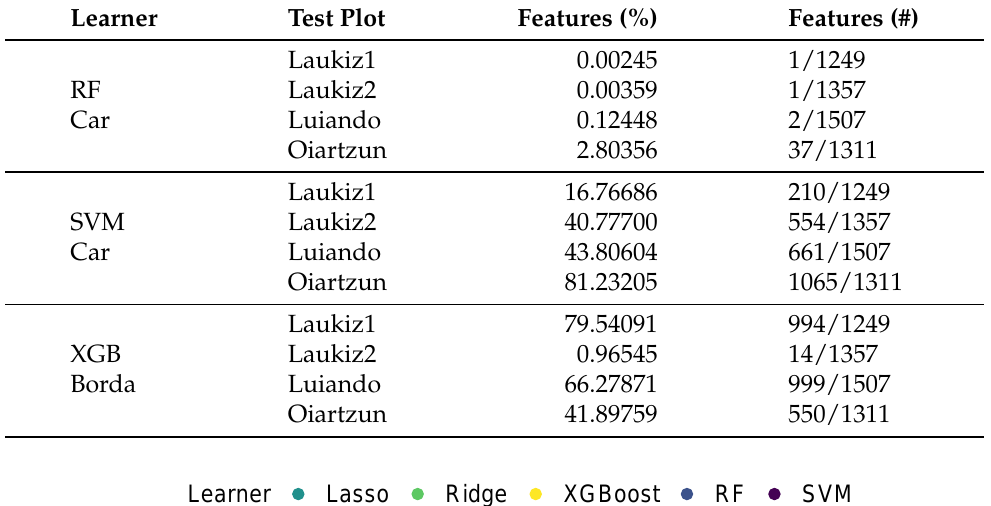
Table 7. Selected feature portions during tuning for the best performing learner–filter settings (SVM Relief, RF Relief, XGBoost CMIM) across folds for task HR-NRI-VI, sorted by plot name. “Features (#)” denotes the absolute number of features selected, and “Features (%)” refers to the percentage relative to the overall features available in the training sets for each plot (Laukiz1 = 1249, Laukiz2 = 1357, Luiando = 1507, Oiartzun = 1311). Results were estimated in a separate model tuning step, not within the main cross-validation comparison.